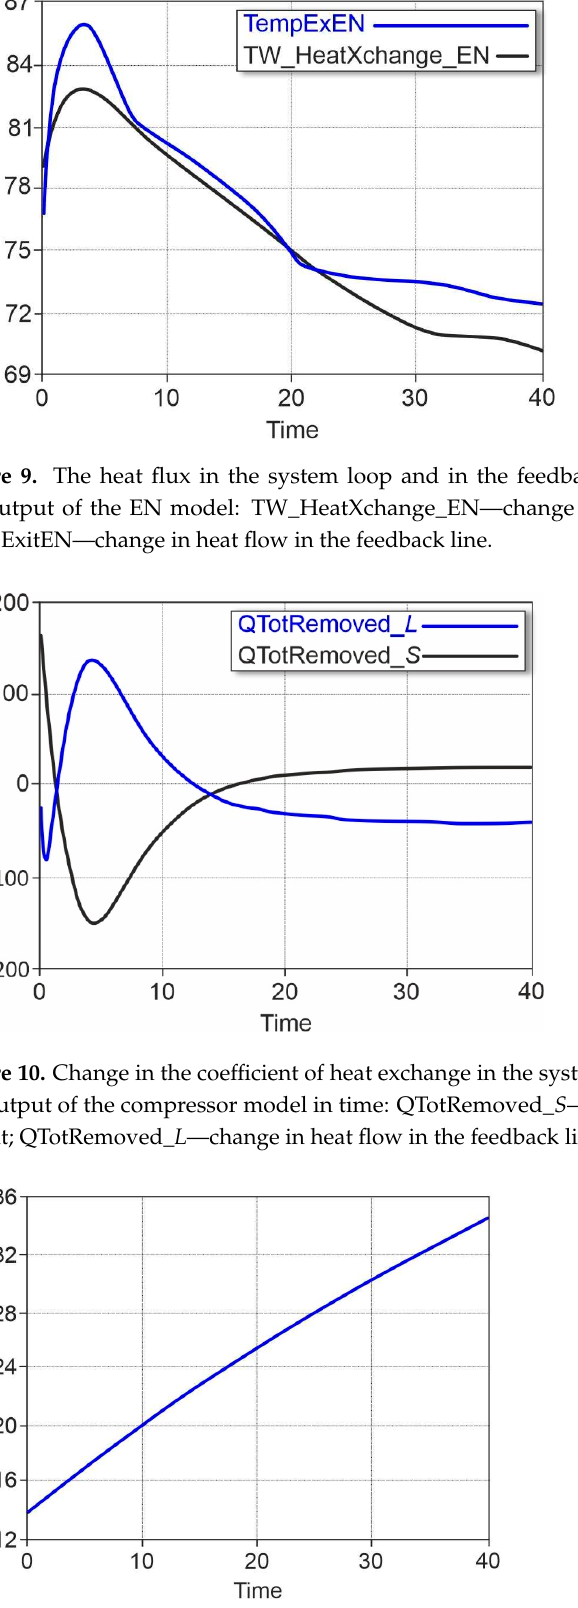
Figure 11. Blood temperature in the cardiopulmonary bypass circuit at the output of the heart-lung machine.